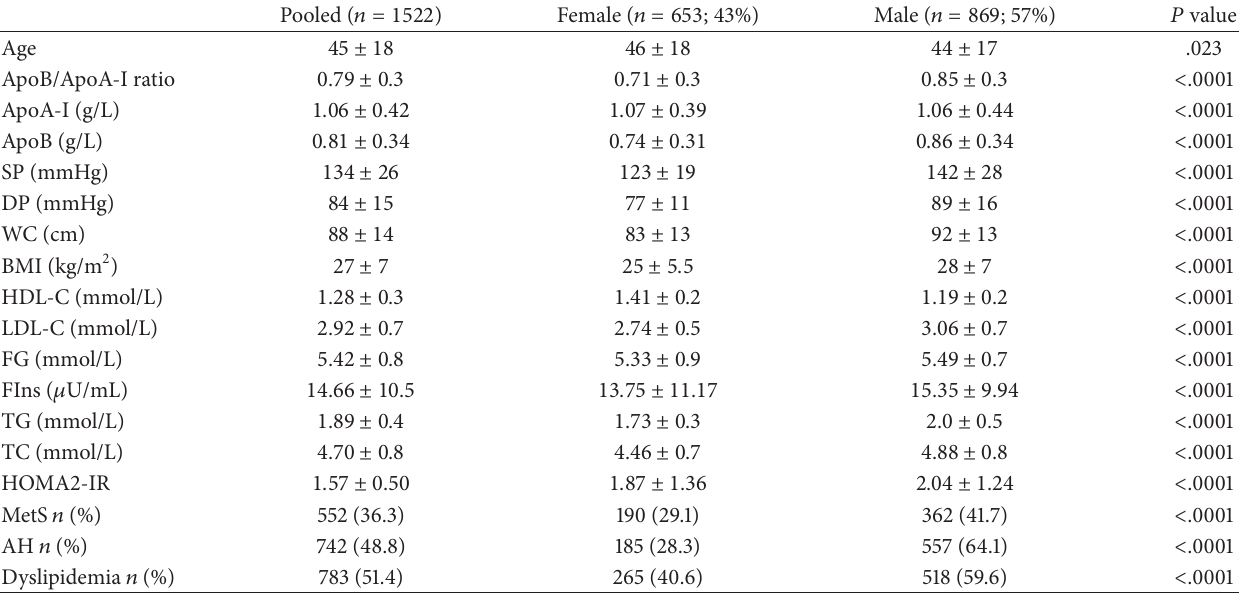
Table 1: Descriptive characteristics between sexes.